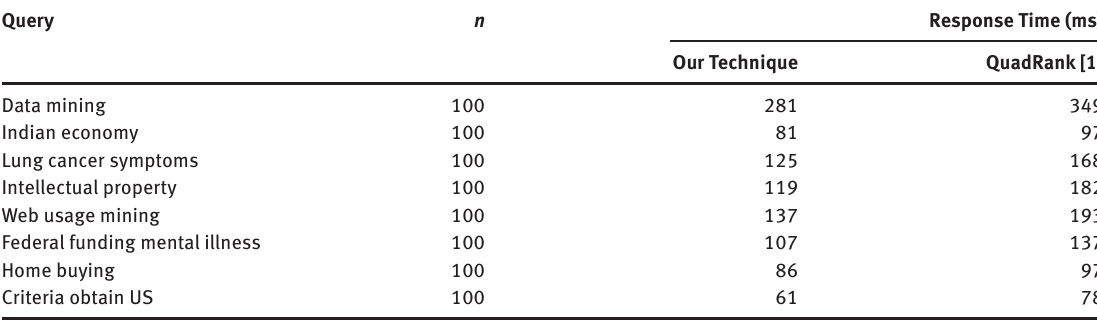
Table 4: Response Time Comparison in Terms of Top 100 Links. Query